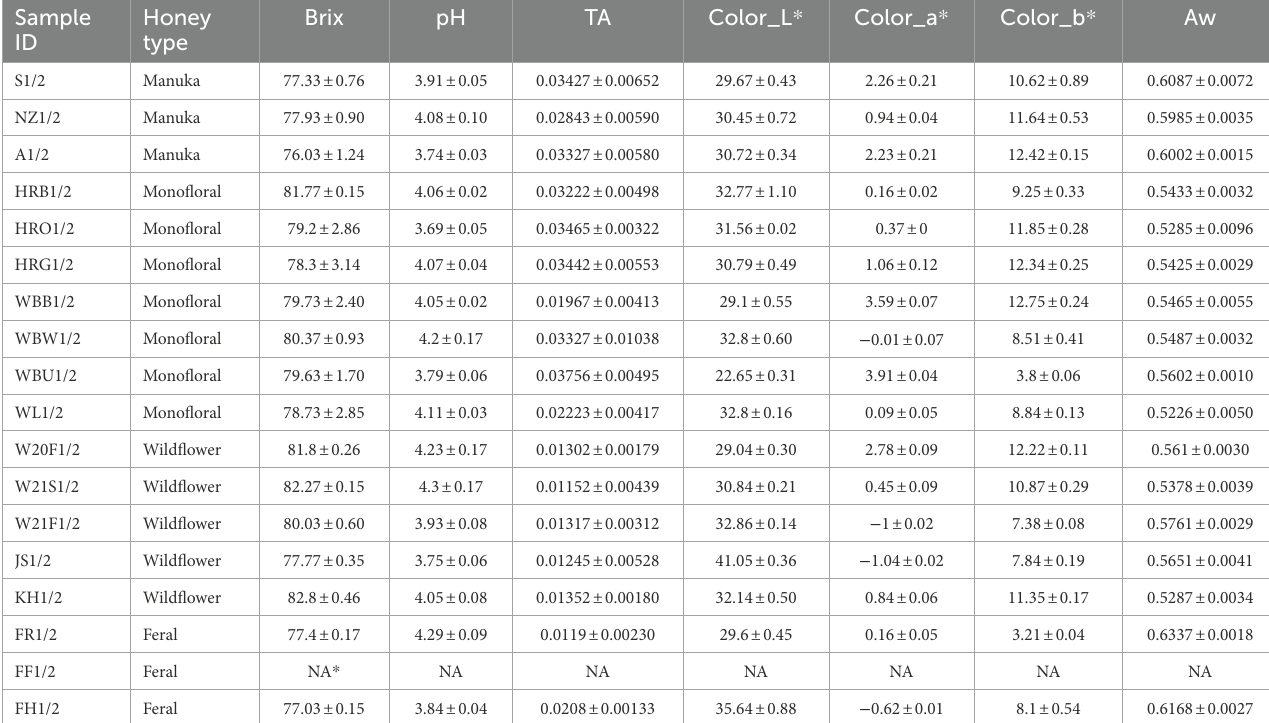
TABLE 1 Physicochemical properties of